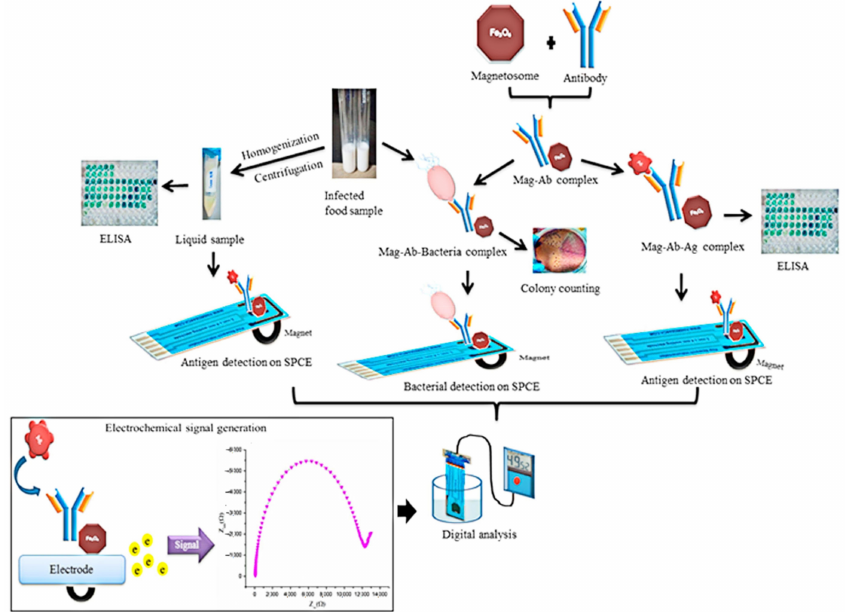
Figure 17. Schematic illustration of lipopolysaccharide and Salmonella typhimurium detection using magnetosome-anti-Salmonella antibody complex. Reprinted from [229] with permission of Elsevier provided by Copyright Clearance